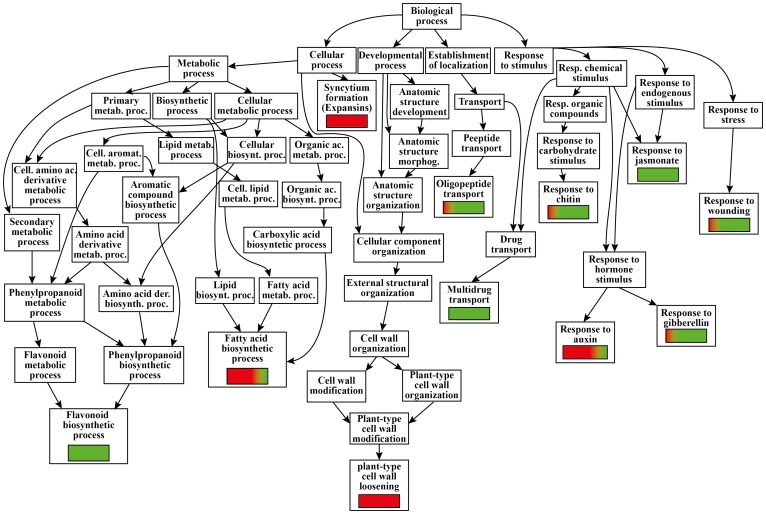
GO analysis of Arabidopsis genes regulated by Myzus persicae herbivory.Red color indicates up-regulation, green color indicates down-regulation.